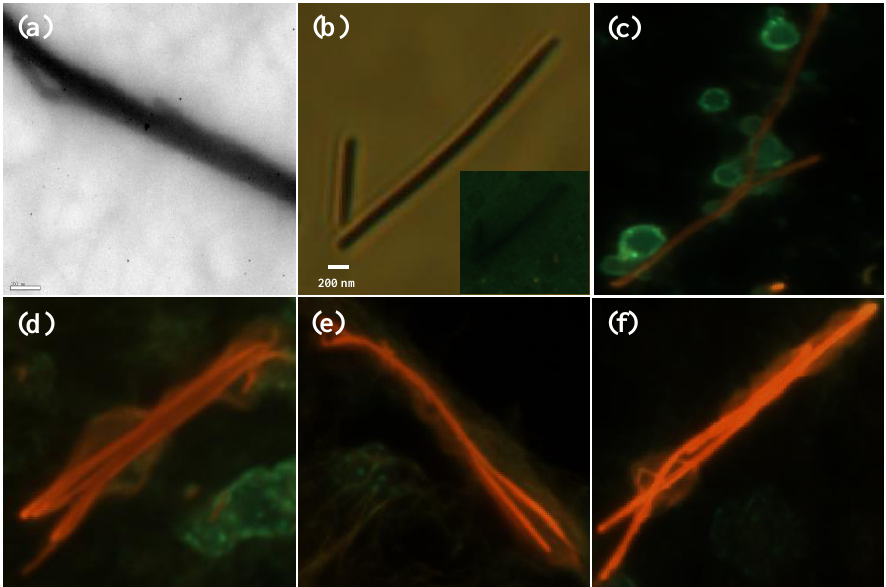
Figure 2. ( a ) TEM image and ( b ) optical image of as-prepared P3MT NW. Charge-coupled devices (CCD) images of ( c ) P3MT/pDNA (10-mer), ( d ) P3MT/pDNA-tDNA (10 – 10 pairs), ( e ) P3MT/pDNA-tDNA (20 – 20 pairs) and ( f ) P3MT/pDNA-tDNA (30 – 30 pairs).